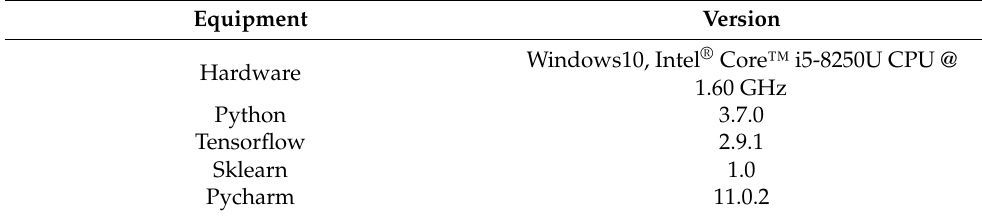
Table 1. Hardware and software equipment and